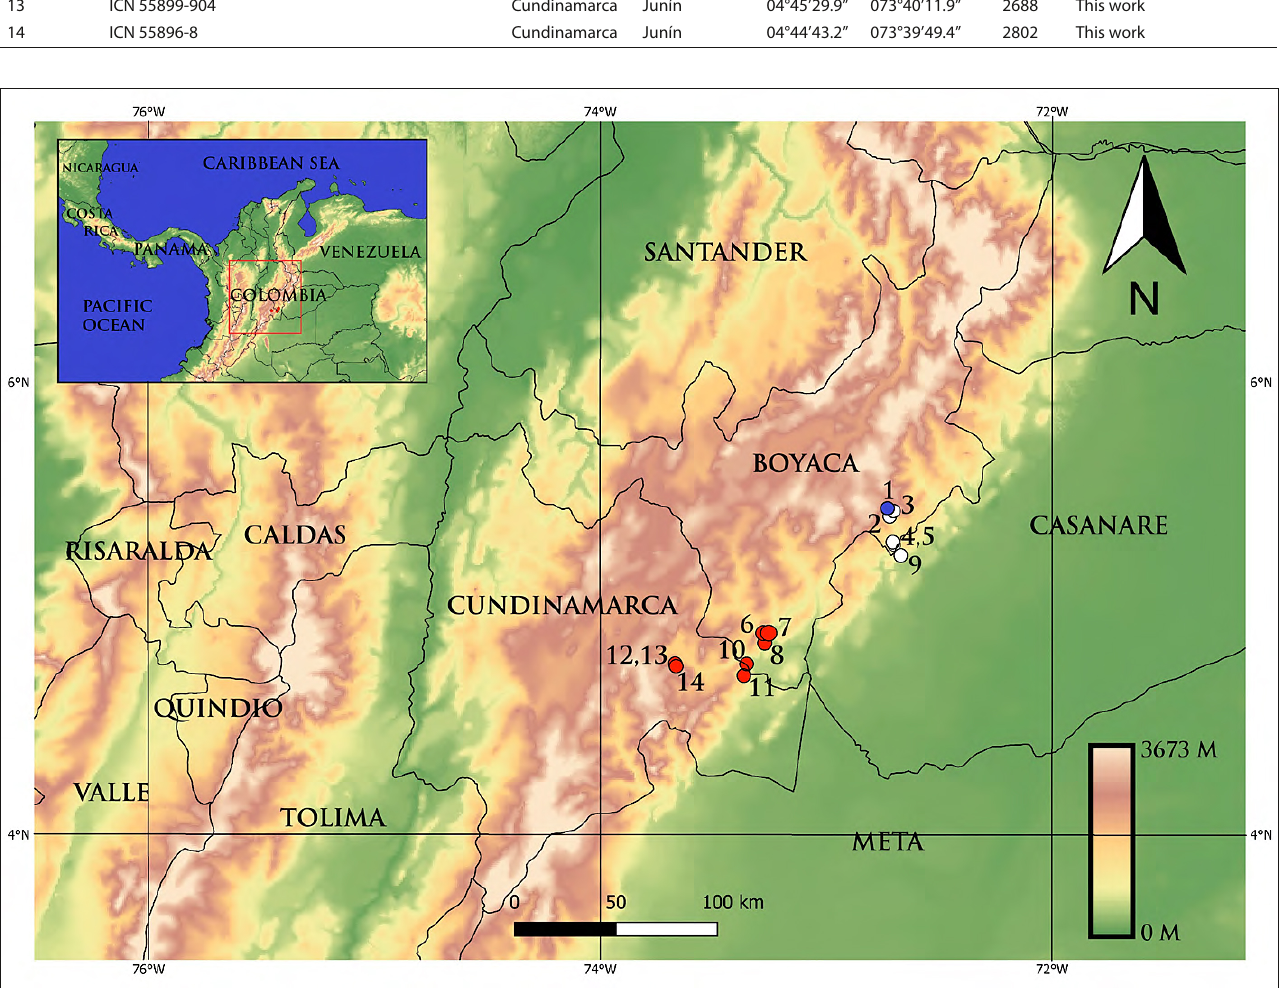
Figure 1. Distribution map of Pristimantis carranguerorum . Red dots correspond to the new localities reported by the present work, white dots refer to the literature records, and the blue dot to the type locality. Each number corresponds to one of the localities referred to in Table 1. The inset map indicates the location of the data points in northwestern South America. The datum used in this map is